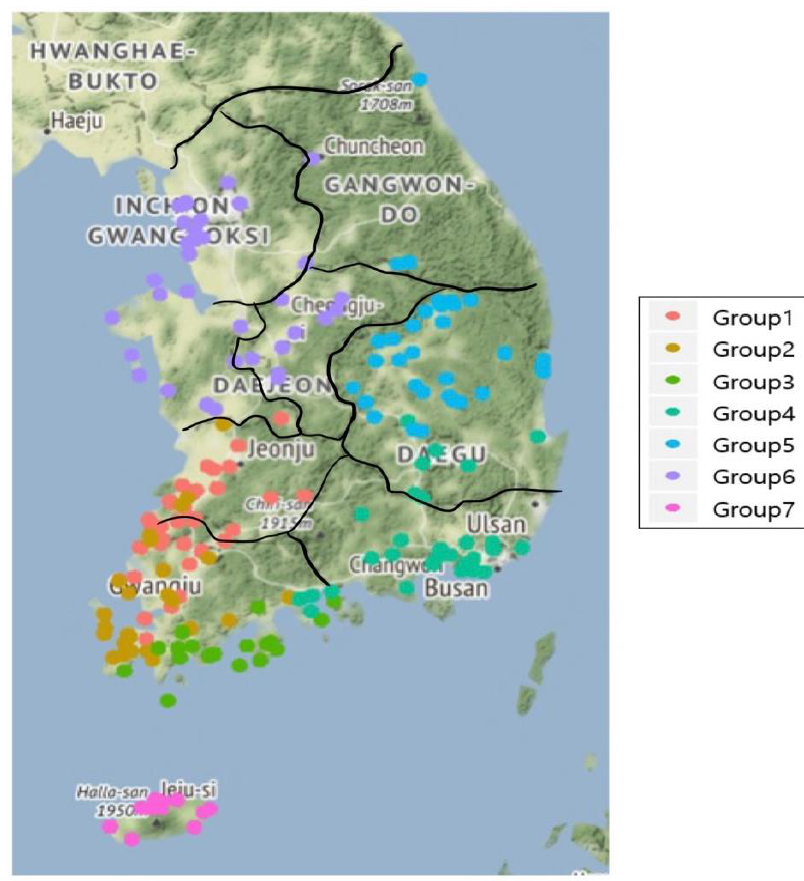
Figure 5. Results of cluster mapping. Table 1. The numbers of solar power plants and regions of the seven groups. Group Number Region